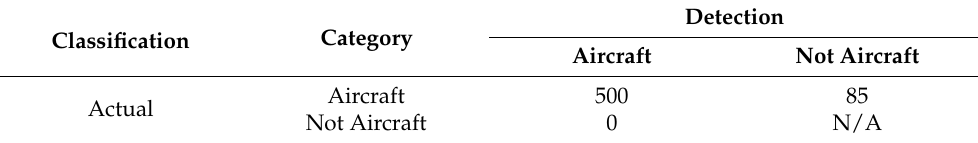
Figure 11. Detection result comparison of faster RCNN, SSD and YOLO. Table 4. Confusion matrix of SSD.